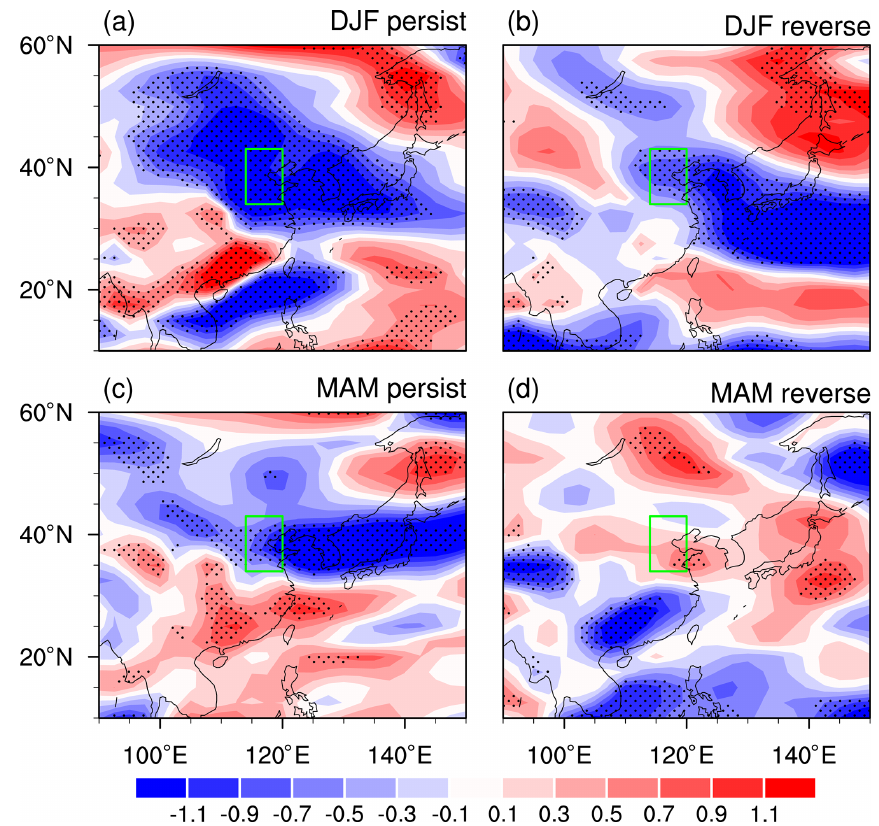
Figure 5. Composite anomalies of 850hPa wind speed (unit ms − 1 ) in (a, b) winter and (c, d) spring in the (a, c) persistent years and the (b, d) reverse years. Stippled regions indicate anomalies that are statistically significant at the 5%